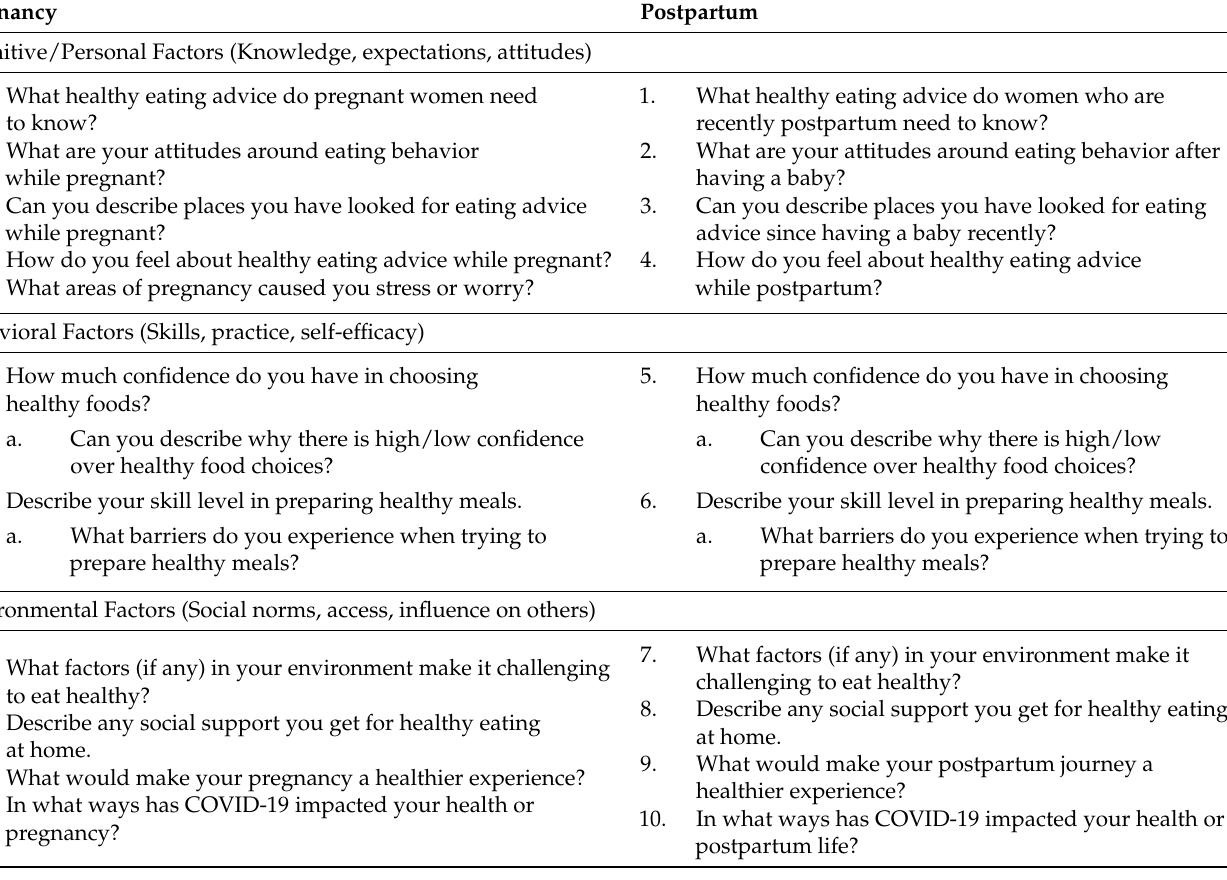
Table 1. Focus Group